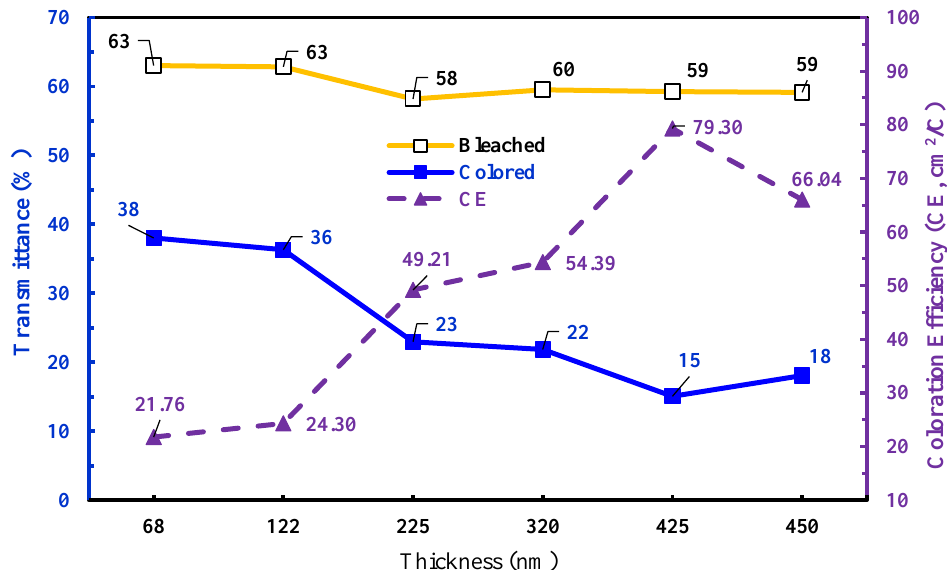
Figure 8. The bleached and colored states (bottom-left axes) and measured CE values (bottom-right axes) in the wavelength range between 400–800 nm, with respect to their different thicknesses of WO 3 films.